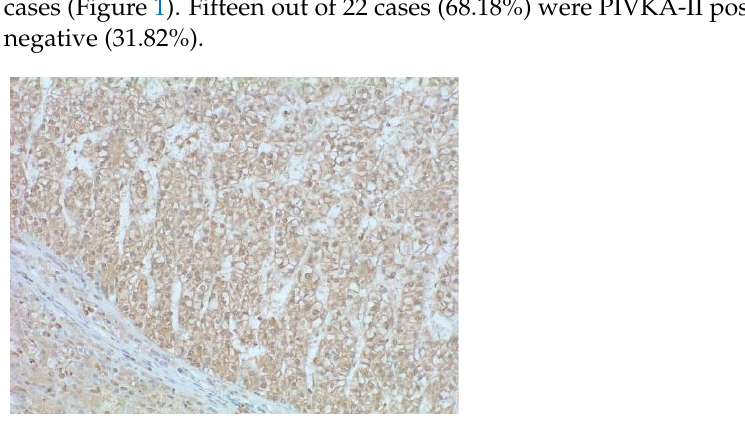
Figure 1. HCC well differentiated (WHO grade) trabecular pattern positive for PIVKA-II. In the image a portion of peritumoural hepatic tissue (bottom left) with a weak cytoplasmic positivity for PIVKA-II is also represented. Peritumoural fibrous capsule is negative.200x magnification – Mayer’s hematoxylin counterstaining.